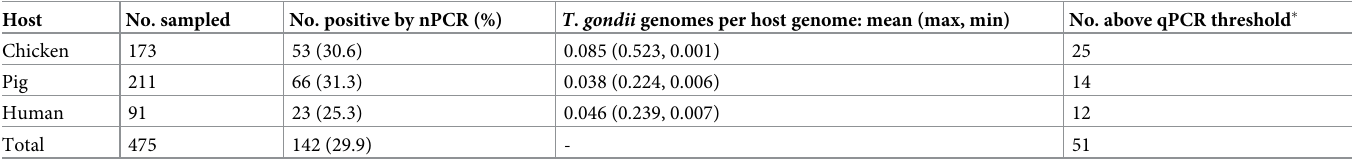
Table 1. Detection of Toxoplasma gondii genomic DNA in thigh muscle samples collected from free-range chickens and pigs, and in blood collected from seroposi- tive pregnant women. Host No. sampled No. positive by nPCR